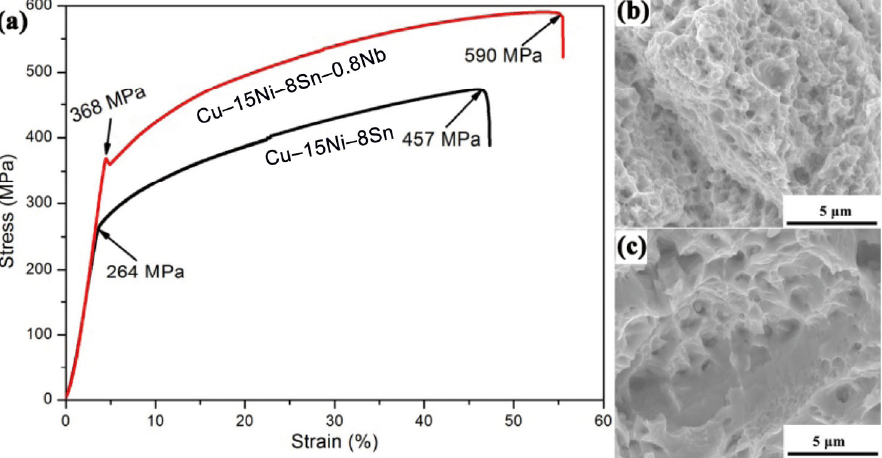
Fig. 5 Stress–strain curves and fractures of the studied alloys after solid solution treatment: (a) stress–strain curves, (b) fracture of Cu 15Ni 8Sn 0.8Nb alloy, and (c) fracture of Cu